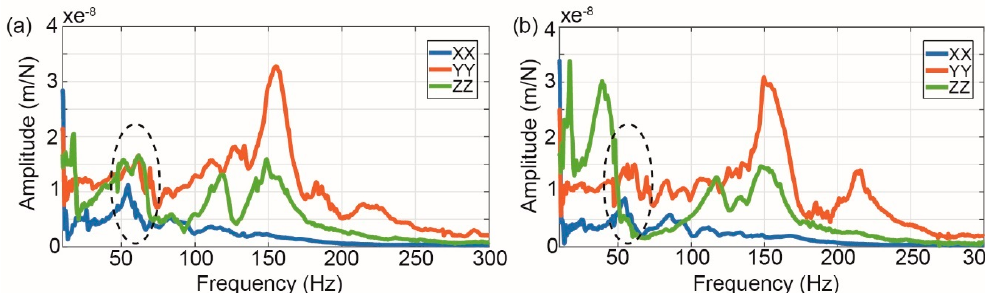
Figure 4. FRF on the ( a ) left turret and ( b ) right turret.